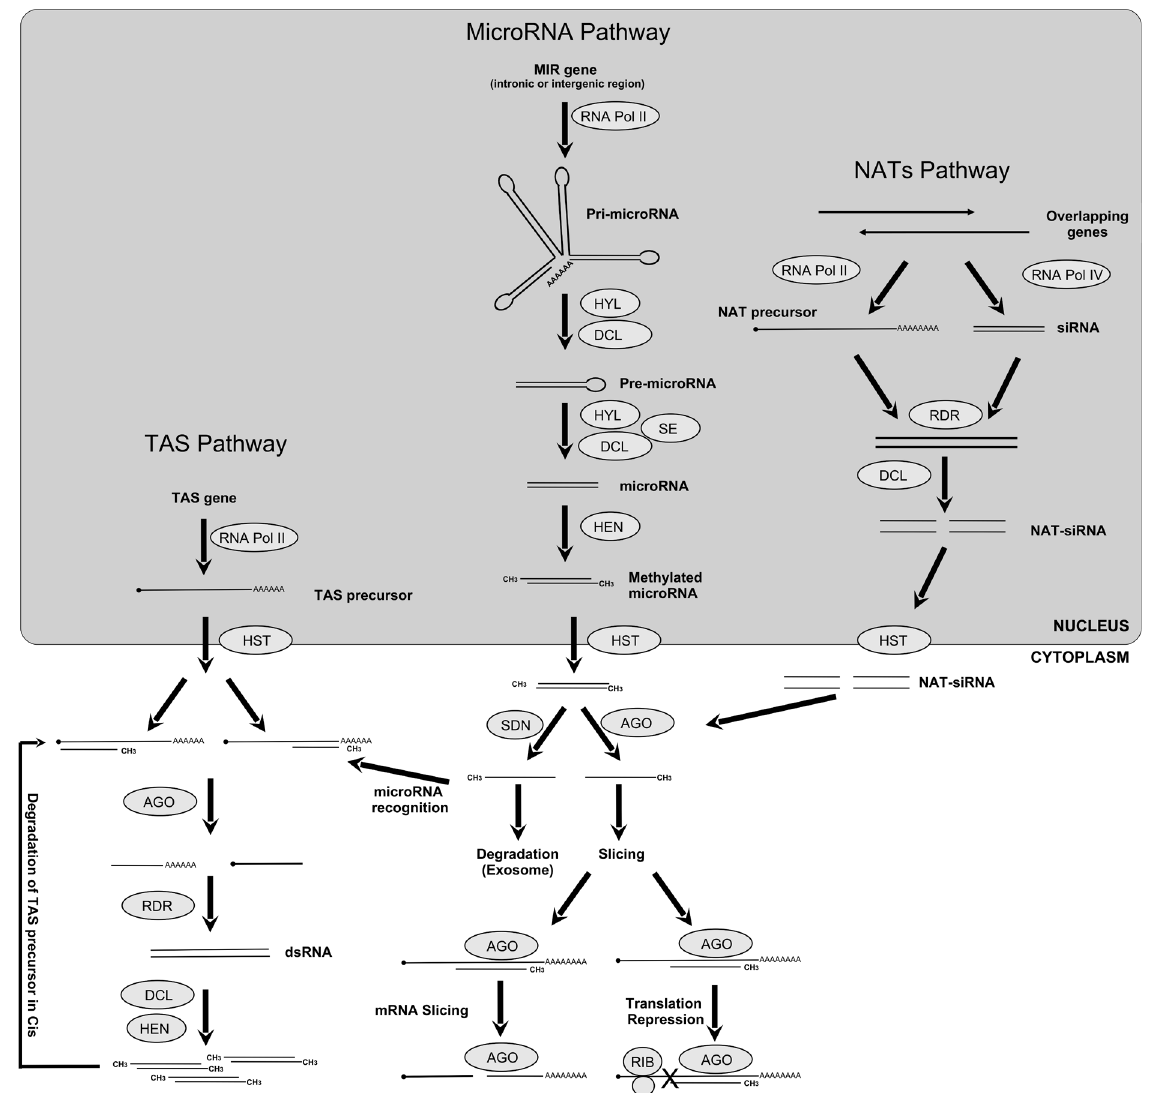
Figure 1 - General view of the small RNA pathways in plants. Cis/Trans-Acting small interfering RNAs (TAS) Pathway: A TAS gene is transcribed by RNA Pol II into a TAS precursor, later this precursor is recognized by a complementary siRNA and sliced by Argonaute (AGO) proteins into small RNA which serves as a template for RNA Dependent RNA Polymerases (RDR) to make dsRNAs. This siRNA duplex originated by Dicer-Like directs cleav - age of the TAS precursor in cis , or another target mRNAs in trans . MicroRNA Pathway: A MIR gene, usually located in intergenic or intronic region, is transcribedbyRNAPolIIintoaprecursorRNAnamedpri-microRNA,whichisstabilizedandcleavedbyaproteincomplexcomposedbyDicer-likepro- teins (DCL) and Hyponastic Leaves (HYL) into a pre-microRNA which is further processed by the same complex plus Serrate (SE) into a mature microRNA. The HUA Enhancer (HEN) methylates the resulting mature microRNA form in the 2’-hydroxy termini of both strands. This methylated ma- ture form is exported to cytoplasm through HASTY protein (HST). Once in the cytoplasm, AGO proteins recognize one strand of the mature microRNA anddirectittothetargetgene.Later,theAGOcaninducetheslicingofmRNAtargetorrepressthetranslationcomplex.TheothermicroRNAstrandisdi- rected to the Exosome and degraded by Small RNA Degrading Nuclease (SDN). Natural Acting Small RNAs (NAT) Pathway: Overlapping genes can be transcribed by RNA Pol II, resulting in a NAT precursor complementary to an siRNA, which serves as a template to the RDR proteins. The DCL protein cleaves this double-stranded precursor into dsRNAs, which are exported to the cytosol by HST protein. The NAT-siRNAs loaded into AGO complexes induce mRNA degradation in the same way as for microRNA